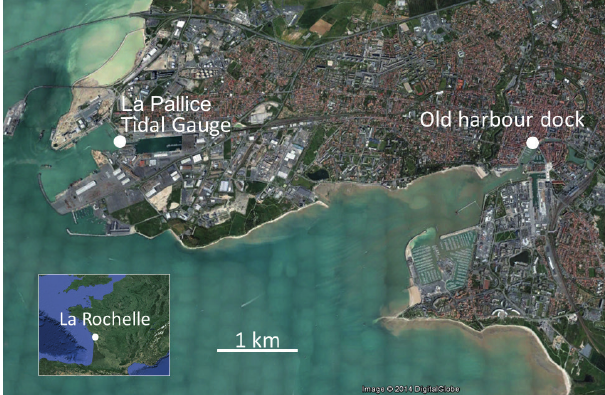
Figure 2. Input data: hourly tide-gauge measurements after remov- ing the linear trend (black: until the end of 2009; blue: 2010; grey: 2011–2013) and historical information (black dotted lines). The red line represents the position of the perception threshold (7.1m